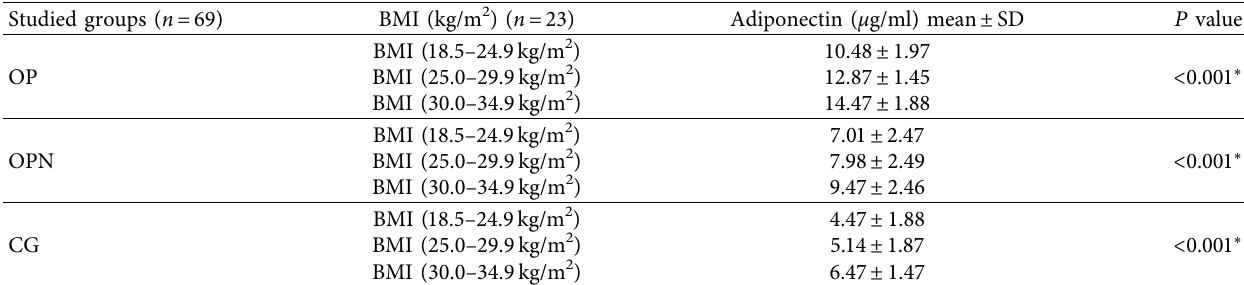
OP, osteoporosis group; OPN, osteopenia group; CG, control group; n , no. of subjects; BMI, body mass index; BMD, bone mineral density; L, lumbar; F, femoral neck; ALP, alkaline phosphatase; CTX, serum human C-terminal telopeptides of types I collagen; PICP, serum human carboxyterminal propeptide of type I procollagen. Data are means ± SD. Table 2: Comparison of serum adiponectin ( μ g/ml) in the studied groups.